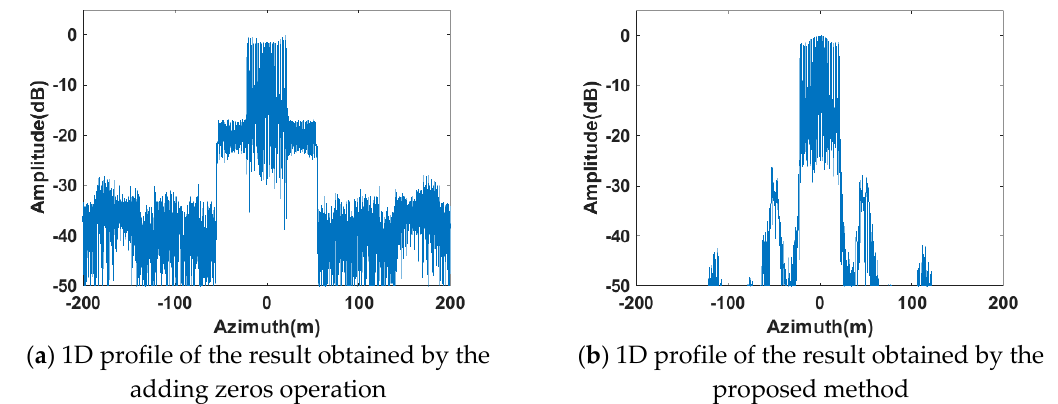
Figure 20. 1D profiles of results at 150 m in range direction: ( a ) 1D profile of the result obtained by the adding zeros operation; and ( b ) 1D profile of the result obtained by the proposed method.